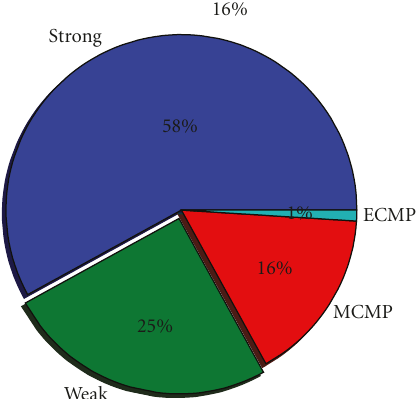
Figure 6: Quality of path: path correspondence. sensing intensity (number of sensor nodes generating data) and the probability of meeting the reliability constraints ( β ) on the e ffi ciency of the ECMP model. LDPR is a